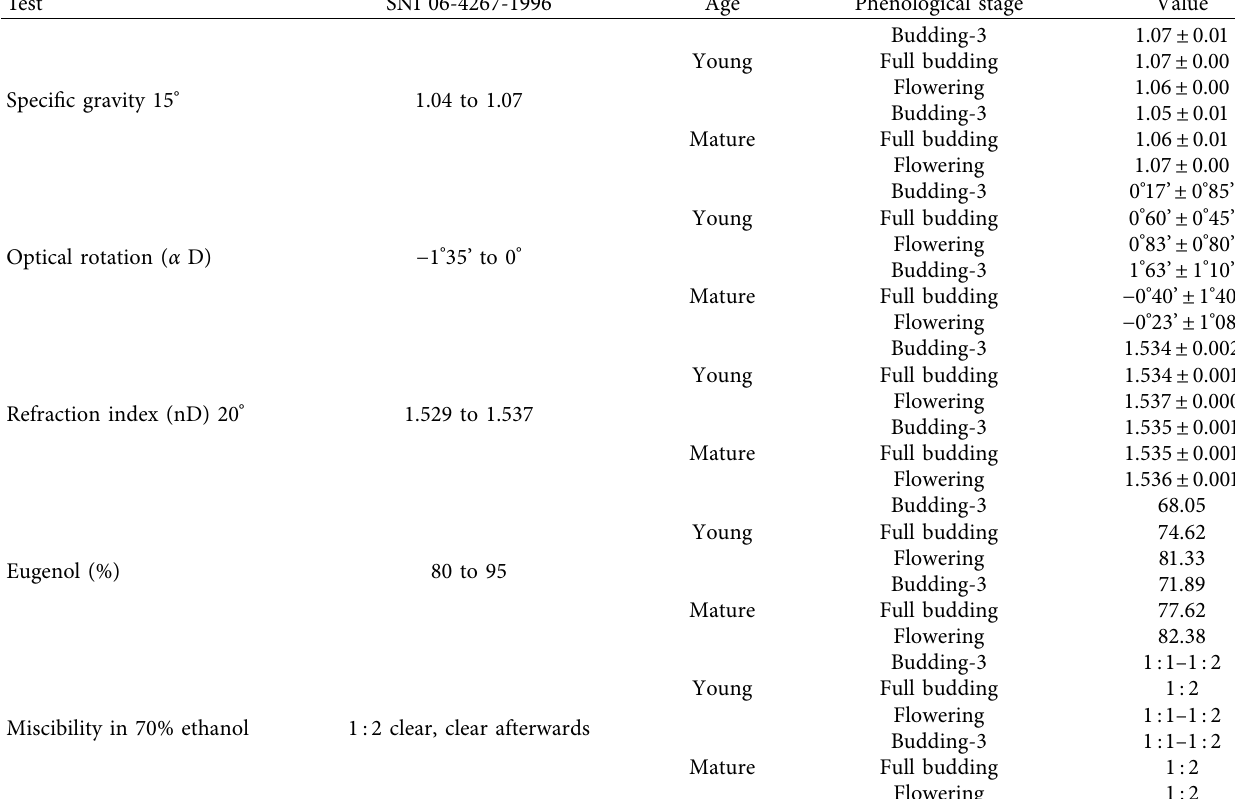
Table 3: Physicochemical properties of clove bud oil in different ages and phenological stages.